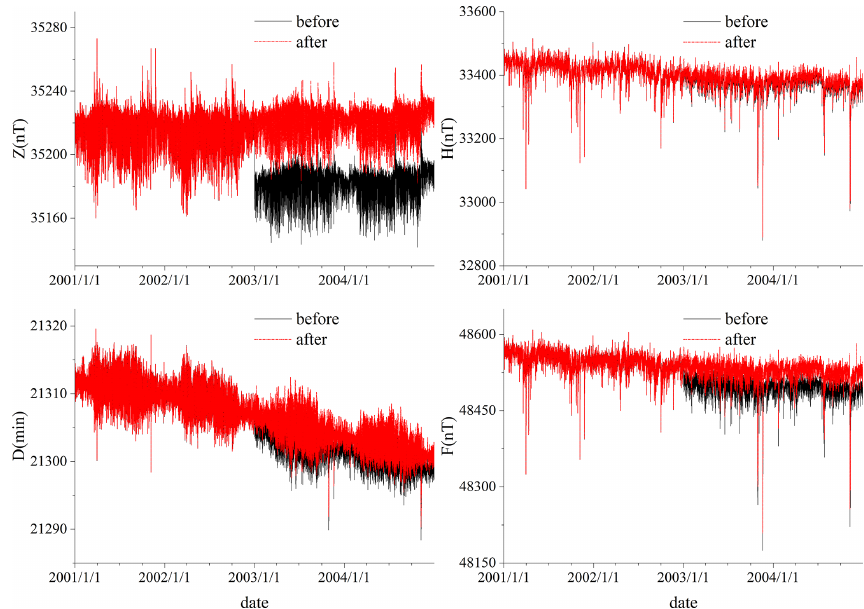
Figure 11. Plot of hourly mean values before and after